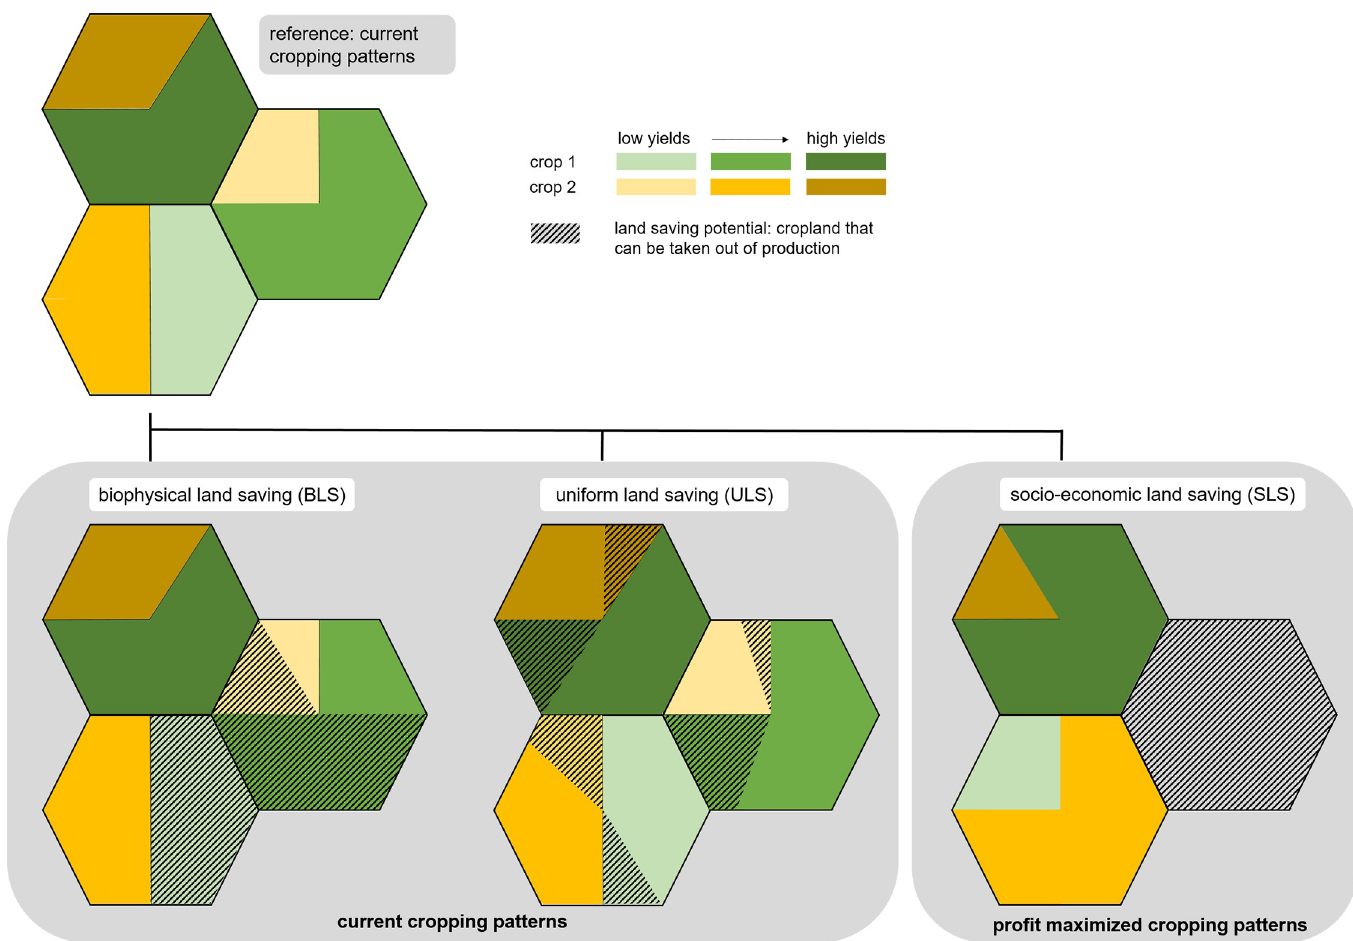
Fig 1. Schematic overview of the three different land saving strategies biophysical land saving (BLS), uniform land saving (ULS) and socio-economic land saving (SLS). The strategies differ in their assumptions on maintaining current cropping patterns (BLS, ULS) versus their change towards profit-optimized cropping patterns (SLS), and the spatial implementation of land saving at locations with the lowest yields (BLS), uniformly across the region at high- and low-yielding locations (ULS), or the least profitable locations (SLS).